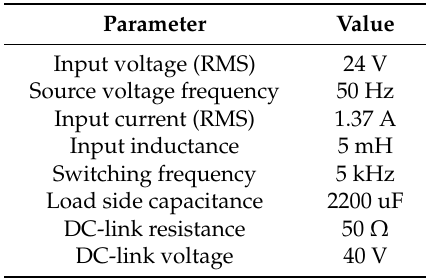
Table 3. The main parameters of the experiments.